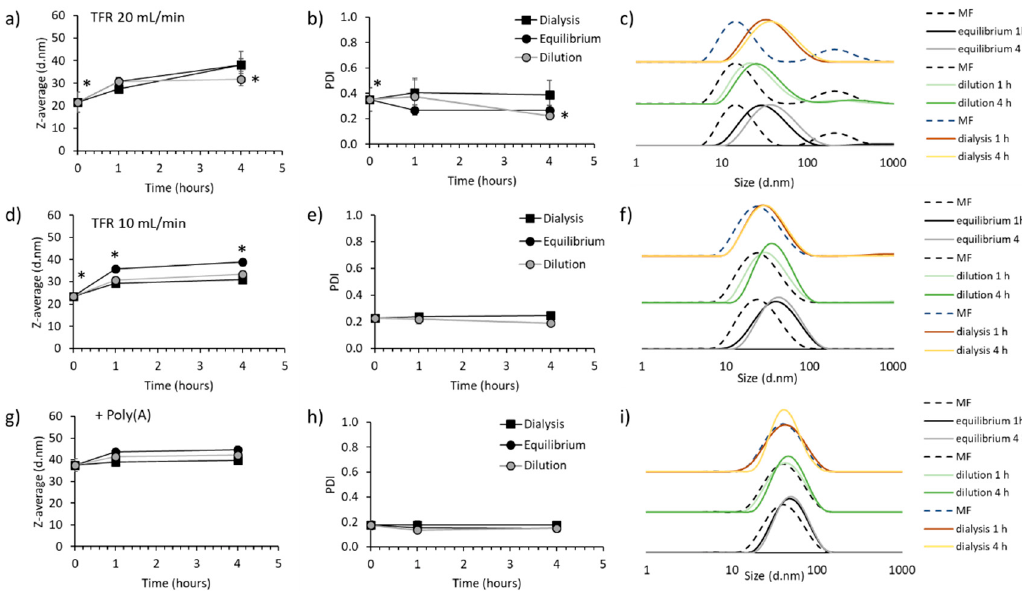
Figure 6. Stability study on the production of DOTAP-cLNPs produced at 3:1 FRR using TRIS pH 7.4 10 mM as the buffer choice. cLNPs were produced using microfluidics (MF) followed by either dilution in citrate buffer (5-fold), dialysis against TRIS buffer or equilibrated at room temperature (no solvent removal). DLS measurements were taken at times 0, 1 and 4 h. ( a ) Particle size, ( b ) PDI, and ( c ) intensity plots of empty DOTAP-cLNPs produced at 20 mL / min TFR. ( d ) Particle size, ( e ) PDI, and ( f ) intensity plots of empty DOTAP-cLNPs produced at 10 mL / min TFR. ( g ) Particle size, ( h ) PDI, and ( i ) intensity plots of empty DOTAP-cLNPs loading PolyA at N / P 8 and produced at 20 mL / min TFR. Results represent the mean of at least 3 independent batches and the standard deviation is plotted as error bars. Significant differences are shown as * p < 0.05.